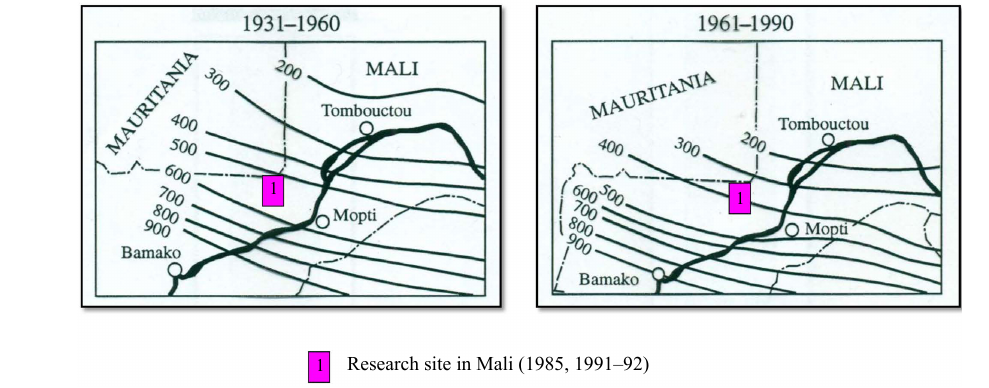
Figure 9. Location of average isohyets at CLINO 1 (1931–1960) and CLINO 2 (1961–1990); the position of research areas is indicated by the red box (modified after Kusserow and Oestreich,